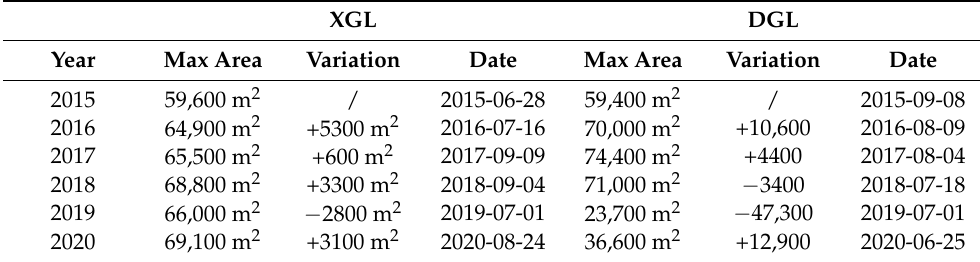
Table 1. Annual largest storage area and corresponding date statistics for DGL and XGL from 2015 to 2020. The variation is calculated by subtracting the area of the two adjacent